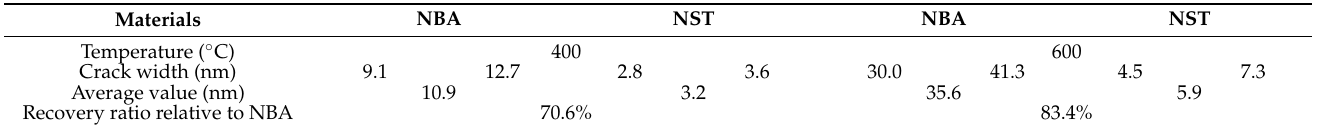
Figure 14. EDS pro fi les of the box labeled areas presented in Figure 13b,d: area A ( a ), area B ( b ), area C ( c ) and area D ( d ).